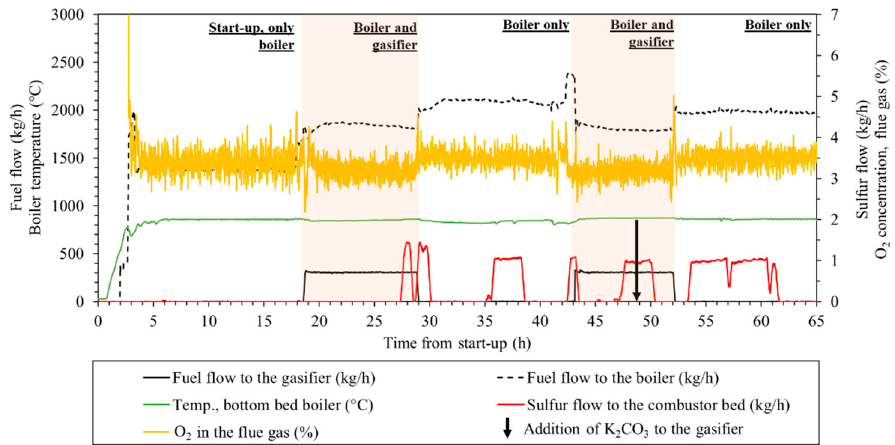
Figure 3. Overview of selected operating parameters of the Chalmers DFB system during the first 65 hours of operation from start-up (i.e., time zero) with a bed of fresh olivine. The tests that included the gasifier are marked as “Boiler and gasifier”.